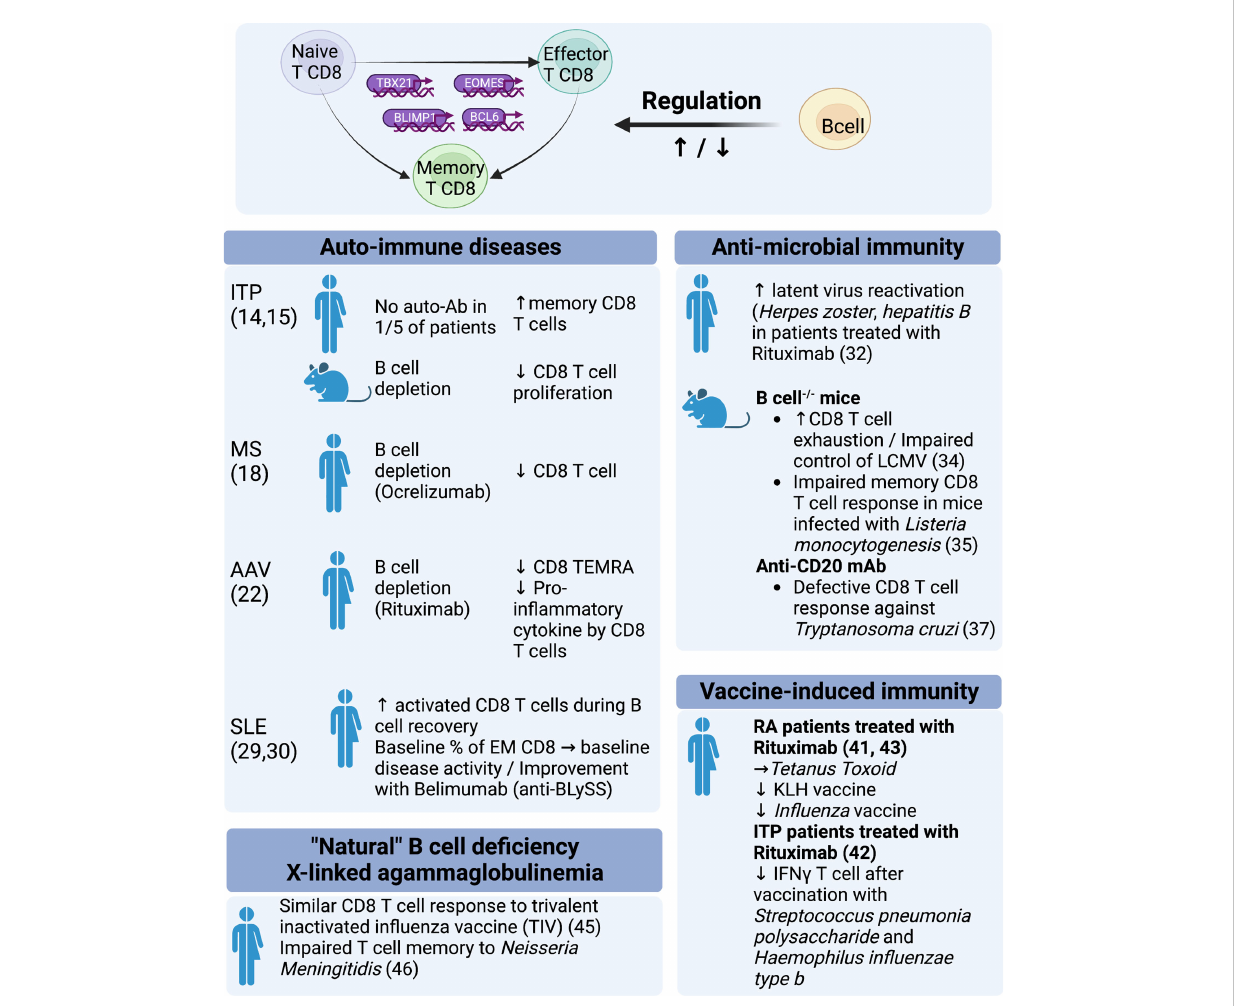
FIGURE 1 Regulation of CD8 function by B cells: evidence from experimental models and clinical